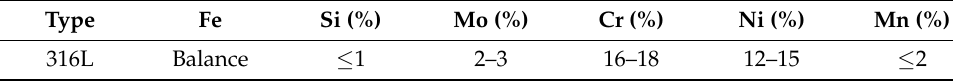
Table 2. Mass fraction of 316L (wt %).